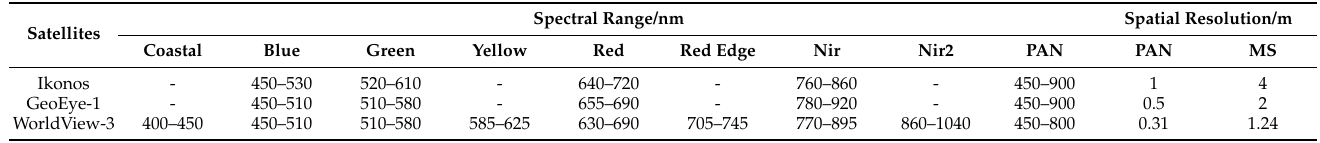
Table 1. The main characteristics of three satellites.